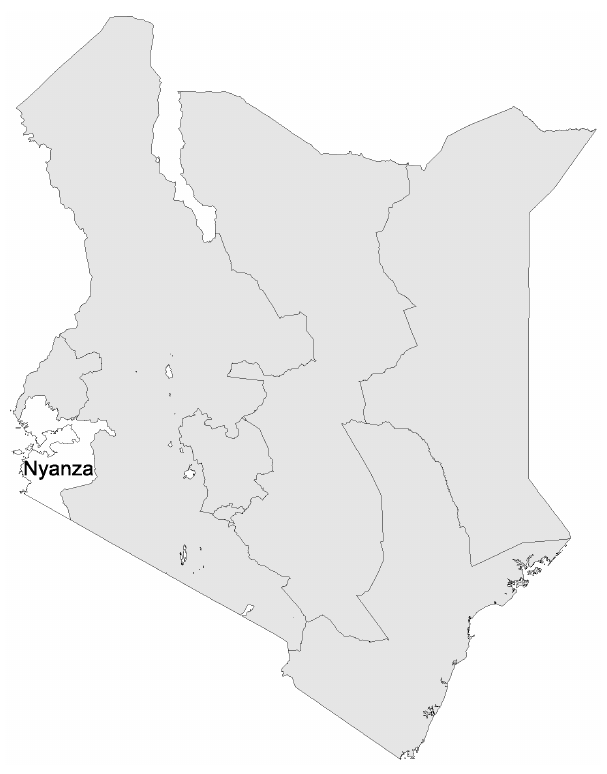
Figure 1. Map of Kenya fieldsite.